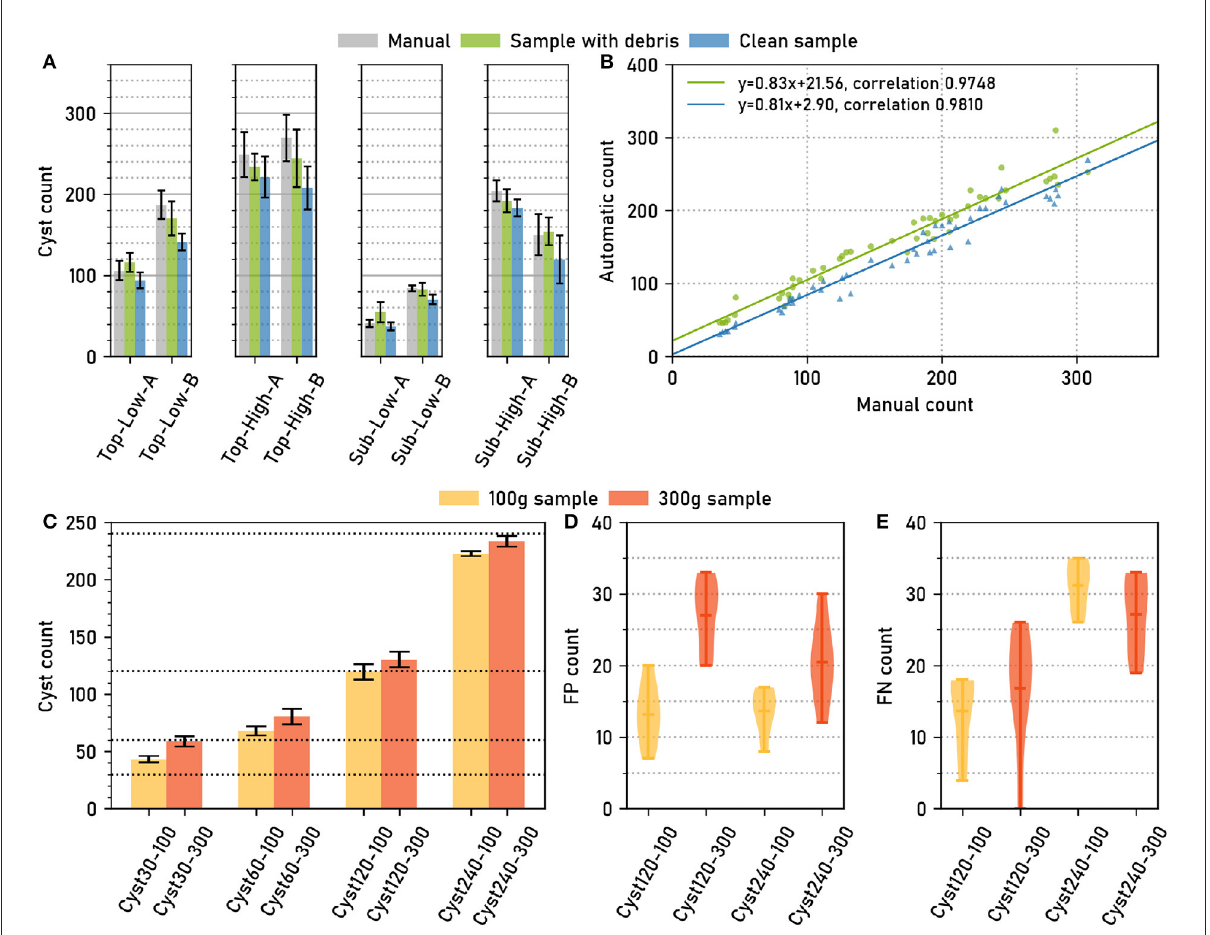
FIGURE2 The computer vision pipeline produces accurate cyst counts: Comparison with manual counts. (A) Data set Cyst-Count (Table 1): Manual and automatic cyst count on samples with debris particles, as well as automatic count on clean samples without debris for different types of soil samples. N = 6 samples per bar. (B) Data set Cyst-Count : Manual count vs. automatic count on samples with debris and on clean samples. N = 2 × 4 × 6 samples. (C) Data set Cyst-Count-Artificial : Automatic count on samples with 30 / 60 / 120 / 240 cysts transferred to cyst-free extracts from 100g and 300g soil samples, respectively. The correct cyst numbers are marked by dotted lines. (D) Data set Debris : Automatic count on the control samples without cysts, i.e., the number of False Positives (FP). N = 12 samples per box plot. Mean FP count (100 g sample): 13.42 ± 3.62. Mean FP count (300g sample): 23.75 ± 6.11. (E) Data set Cyst-Count-Artificial : Estimated number of False Negatives ( # FN). We computed # FN = # P − # TP , where # P is the correct cyst count and # TP = # cyst_detections - # FP , using the FP estimate from the Debris data in d). Mean FN count (120 cysts): 15.25 ± 7.03. Mean FN count (240 cysts): 29.16 ±